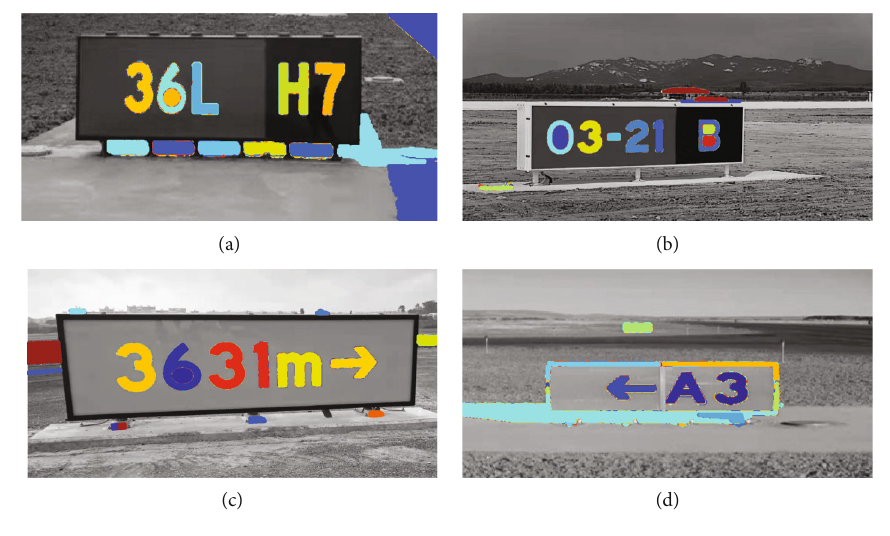
Figure 3: MSER-extracted